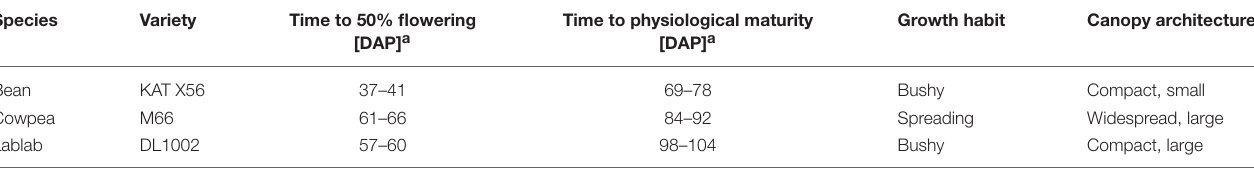
TABLE 2 | Description of phenological development and growth characteristics of short-season grain legumes in semi-arid Eastern Kenya.